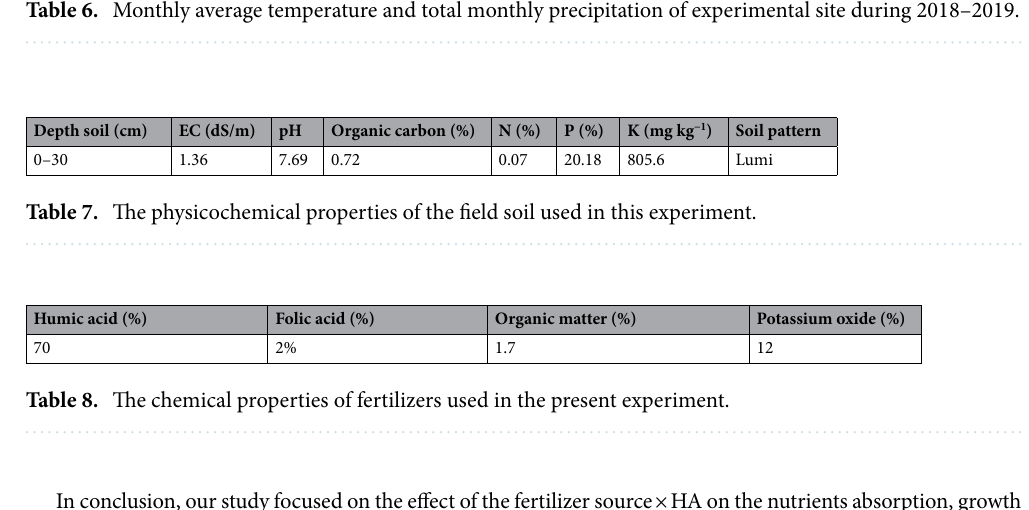
Table 6. Monthly average temperature and total monthly precipitation of experimental site during 2018–2019.